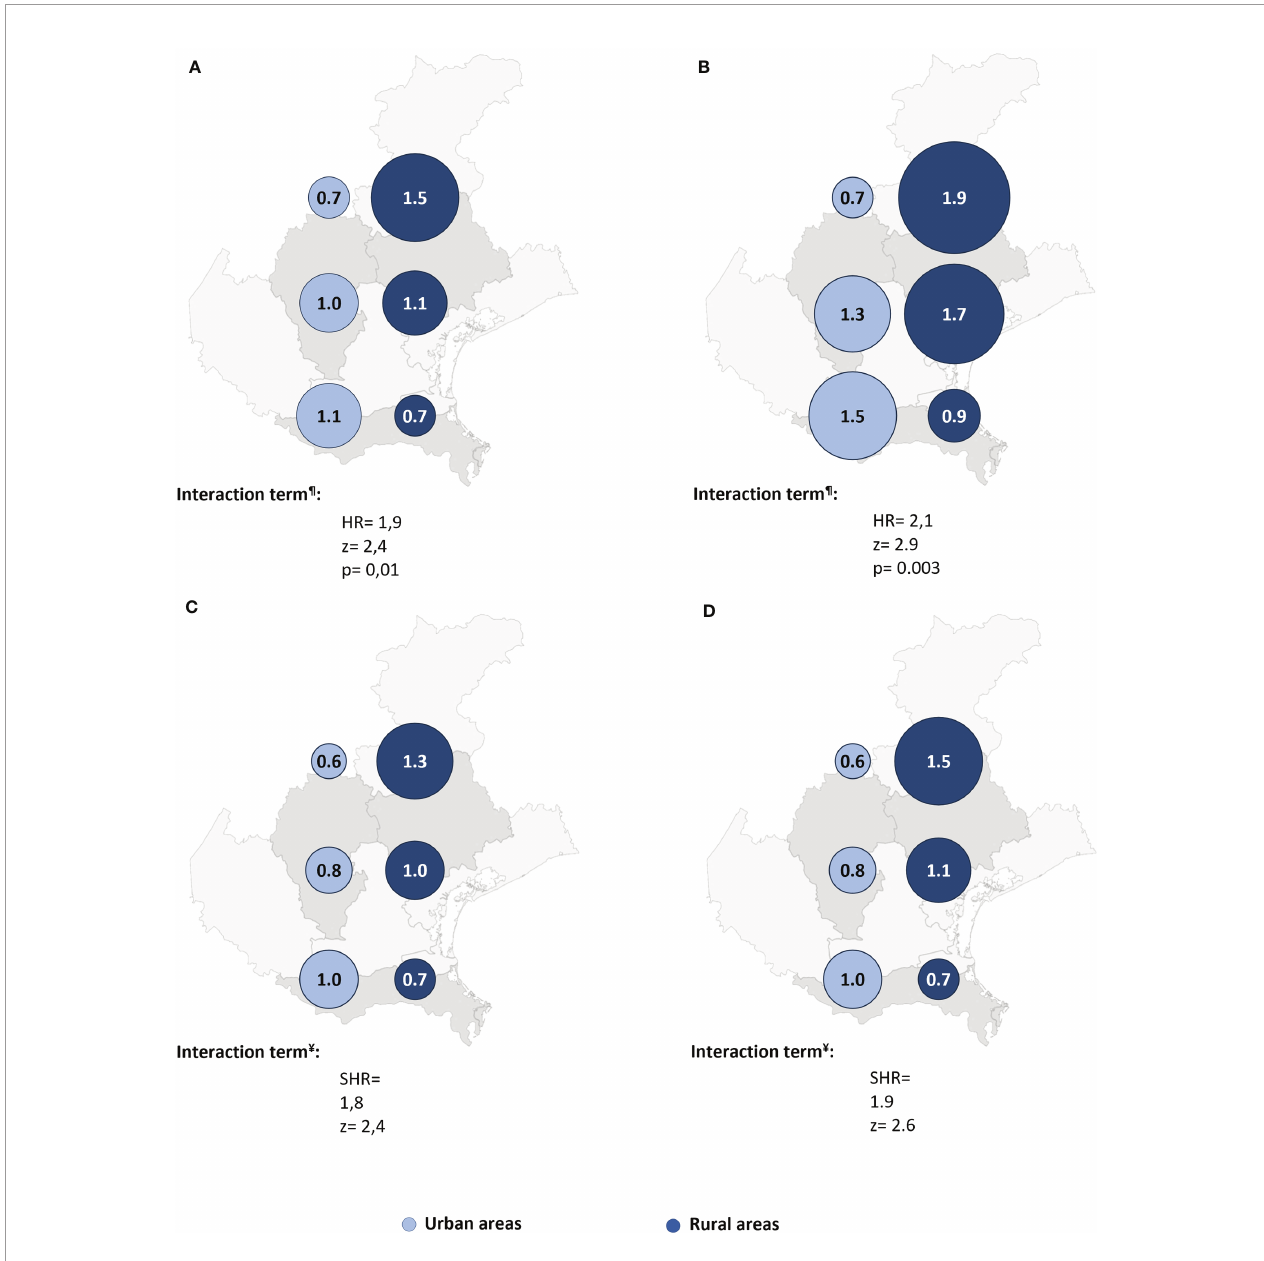
FIGURE 3 | The predicted relative hazards and sub-hazards of neoplastic mortality 22 years after acute coronary syndrome in the six geographic areas (n = 541 patients). HR, Hazard ratio. SHR, Sub-hazards ratio. The relative hazards were calculated using margins post estimation of the unadjusted (A) , and the fully adjusted (B) Cox regression analysis. The relative sub-hazards were calculated using margins post estimation of the unadjusted (C) , and the fully adjusted (D) Fine-Gray competing risk regression analysis. ¶ Calculated using Cox regression analysis. ¥ Calculated using Fine-Gray competing risk regression